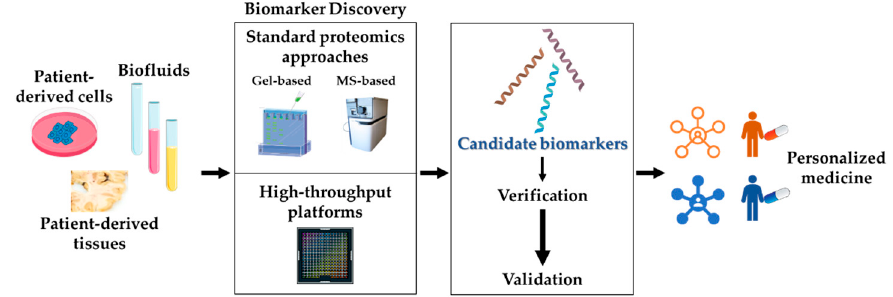
Figure 3. Biomarker discovery by proteomics. Proteomics represents the most promising approach to the identification of reliable disease biomarkers, both in the central nervous system and at the periphery. The discovery phase starts with the choice of the appropriate biological sample (patient ‐ derived biofluids, cells, and tissues). The proteomics analysis is then performed, either by standard methods (see Section 3.1) or by newly developed, automated high ‐ throughput platforms (see Sec ‐ tion 3.2). Candidate biomarkers derived from the discovery phase are then subjected to verification and validation processes. Validated molecules will: (i) work as diagnostic/prognostic indicators; (ii) allow patients’ stratification; (iii) predict individual drug response; key steps towards personalized medicine.